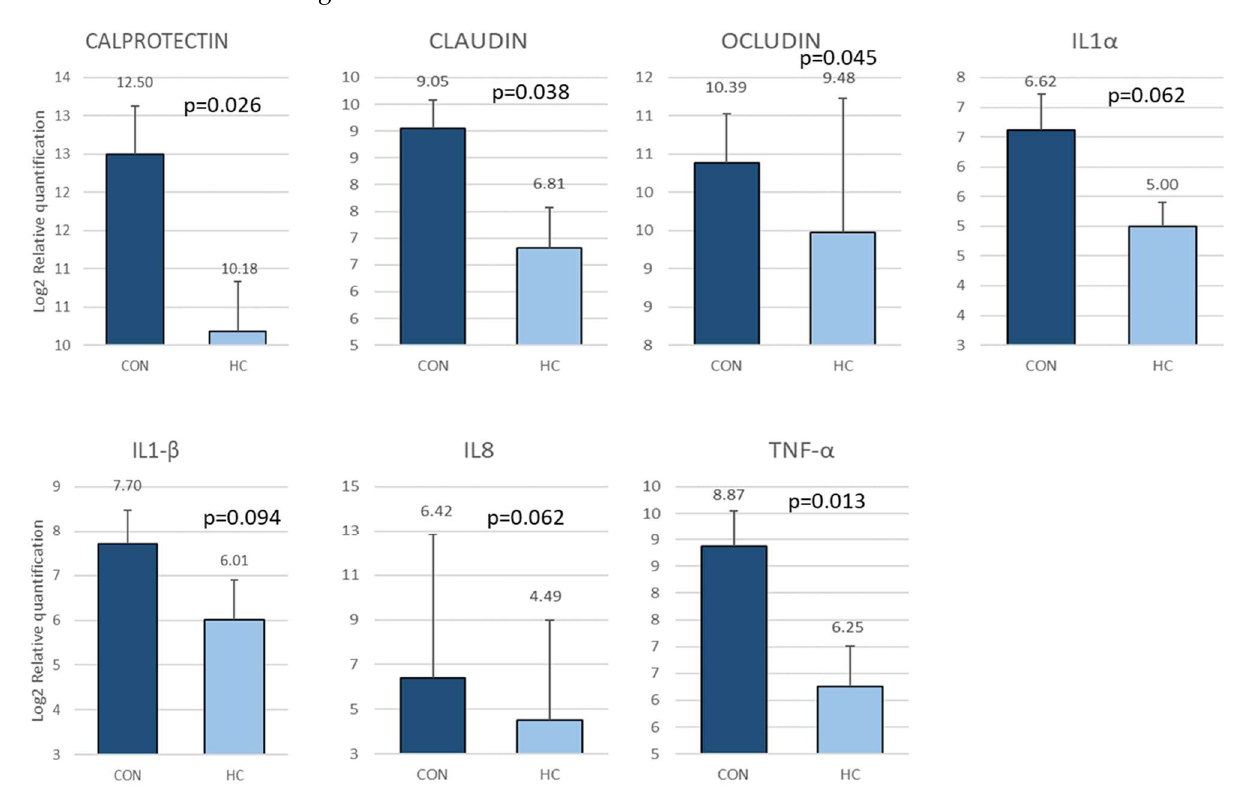
Figure 5. Biomarkers showing differences between CON and HC, expressed as Log2 of relative quantitation on feces in the second sampling. The results are expressed as Log2 of fold change, normalizing against the lower value which was assigned as 1. The bars represent Mean ± SEM.